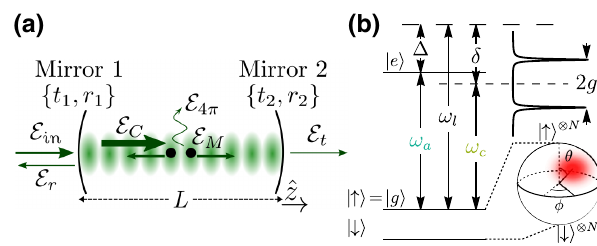
FIG. 1. (a) Schematic diagram of an ensemble of atoms inter- acting with a single-mode cavity of length L . The incident field E E in builds up in the cavity to the value c . The cavity field is coherently scattered by the atoms into the cavity with amplitude E M , and coherently radiated through the cavity mirrors to give the transmitted and reflected fields E t and E r . The cavity field scat- ters from the atoms into free space with amplitude E 4 π , and from the cavity mirrors with amplitude E sc , which is assumed to be zero in a lossless cavity. (b) Level diagram of the atomic three- level system. Here |↑(cid:4) = | g (cid:4) and | e (cid:4) are the two states interacting with the cavity light; ω a , ω c , and ω l are the atomic, cavity reso- nance frequencies, and the probing light frequency, respectively; − ω δ = ω − ω (cid:7) = ω l a and l c are the detunings of probing light from atomic and cavity resonances, respectively. The curve on the right represents the cavity transmission spectrum in the pres- ence of atoms, and 2 g is the vacuum Rabi splitting due to the light-atom interaction when ω a = ω c . The sphere in the bot- tom right represents a Bloch sphere formed by the N atoms of , and the shaded distribution represents a coherent spin spin 1 2 state (CSS) pointing along polar and azimuthal angles ( θ , φ ) in spherical coordinates where each atom is in a superposition state cos (θ/ 2 ) |↑(cid:4) + sin (θ/ 2 ) e i φ |↓(cid:4) . For a CSS pointing along the x axis as in Fig. 1(b), the uncertainties satisfy and saturate the Heisenberg uncer- ˆ (cid:7) S = |(cid:6) [ ˆ S tainty principle (cid:7) S , ] (cid:4)| / 2 = S / 2. Because S √ y z y z = (cid:7) S = of the rotational symmetry, we have (cid:7) S S / 2. √ y z In general, a CSS has a standard deviation S / 2 along any direction perpendicular to its mean spin (cid:6) S (cid:4)